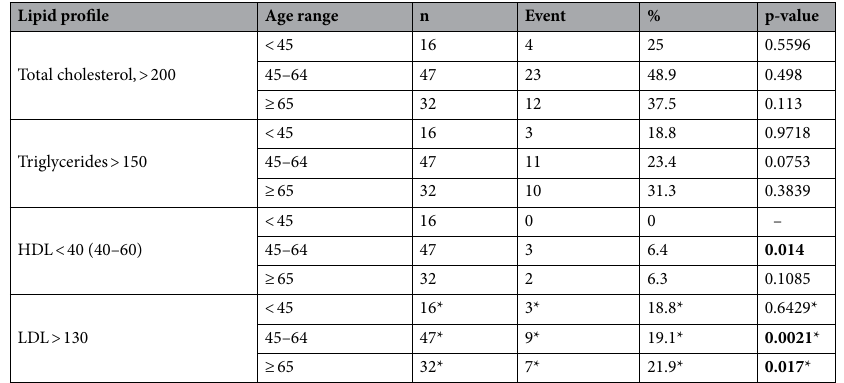
Table 3. The distribution of MGD patients with abnormal lipid profile according to the age range was compared with the average value of the general population using one sample z test. HDL high-density lipoprotein, LDL Low-density lipoprotein. *Since KNHAES did not conduct an LDL survey in 2012, we calculated the LDL concentration using the Friedewald equation for both group of MGD and control.